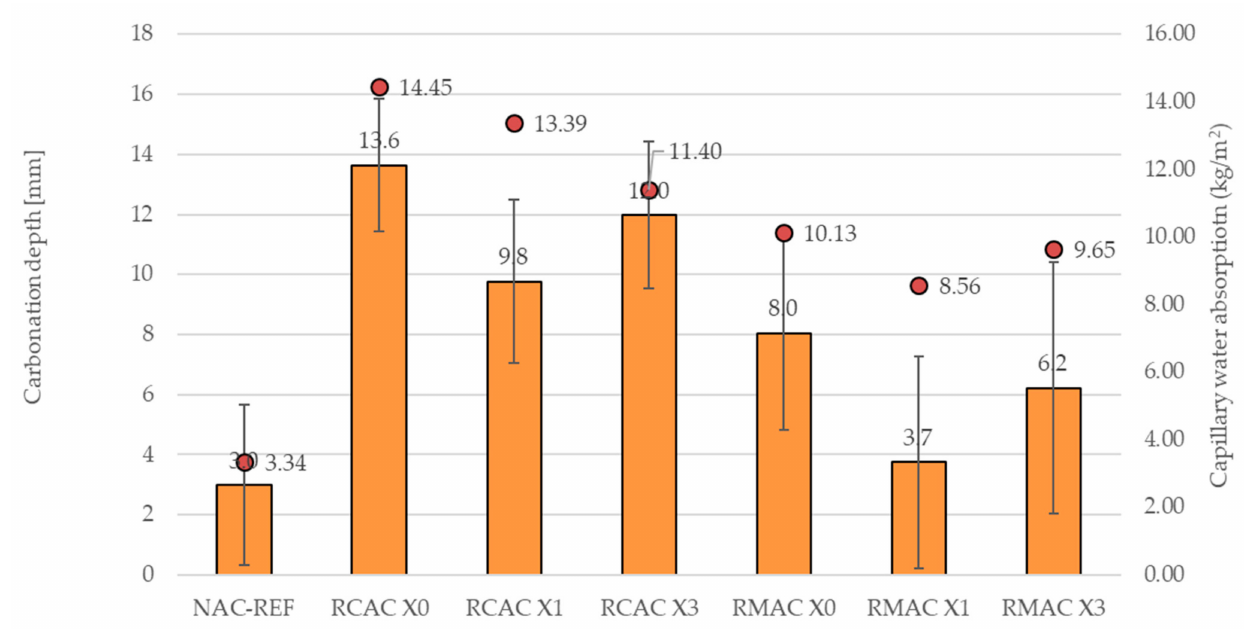
Figure 9. Carbonation resistance—the measured carbonation depth, the indicator increases of mea- sured carbonation depth compared to NAC and correlation with the capillary water